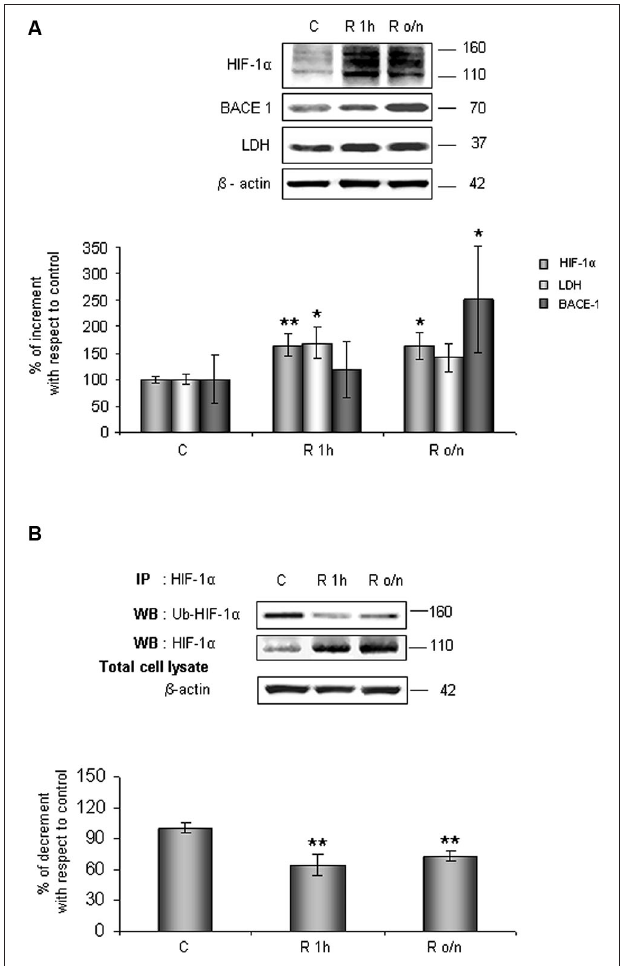
FIGURE 1 | In post-OGD conditions HIF-1 α protein levels increases while its ubiquitination state decreases . Cells were subjected to OGD treatment and restoration of normoxic and glucidic conditions for different times (R 1 h, R o/n). (A) Cells were collected and lysed with 2% SDS lysis buffer. Equal amounts of samples (as protein content) were subjected to SDS-PAGE and western blot analysis. HIF-1 α , LDH, BACE1 levels were detected by specific antibodies, revealed by enhanced chemiluminescence (ECL) and semi-quantitatively determined by a KODAK image station 2000R. Anti- β -actin antibody was employed to confirm equal protein loading in the different lanes. Results obtained are shown on the bar-graphs. Normalization was carried out with respect to the β -actin amount in the same sample. (B) HIF-1 α ubiquitination state was evaluated after immunoprecipitation using western blot analysis. Cells were collected and lysed in non denaturising NP40 buffer. Western blot analysis performed on immunoprecipitated proteins showed bands corresponding to ubiquitinated HIF-1 α protein (140 kDa), HIF-1 α protein (110 kDa). Proteins were detected by specific antibodies (anti-HIF-1 α ; anti-ubiquitin), revealed by ECL and semi-quantitatively determined by a KODAK image station 2000R and the results obtained are shown on the bar-graphs. IP, immunoprecipitation; WB, western blot. Data represent the mean ± SEM of three separate experiments performed in triplicate. Statistical significance is obtained with Student’s t -test in comparison with controls. ∗ p < 0.05, ∗∗ p <